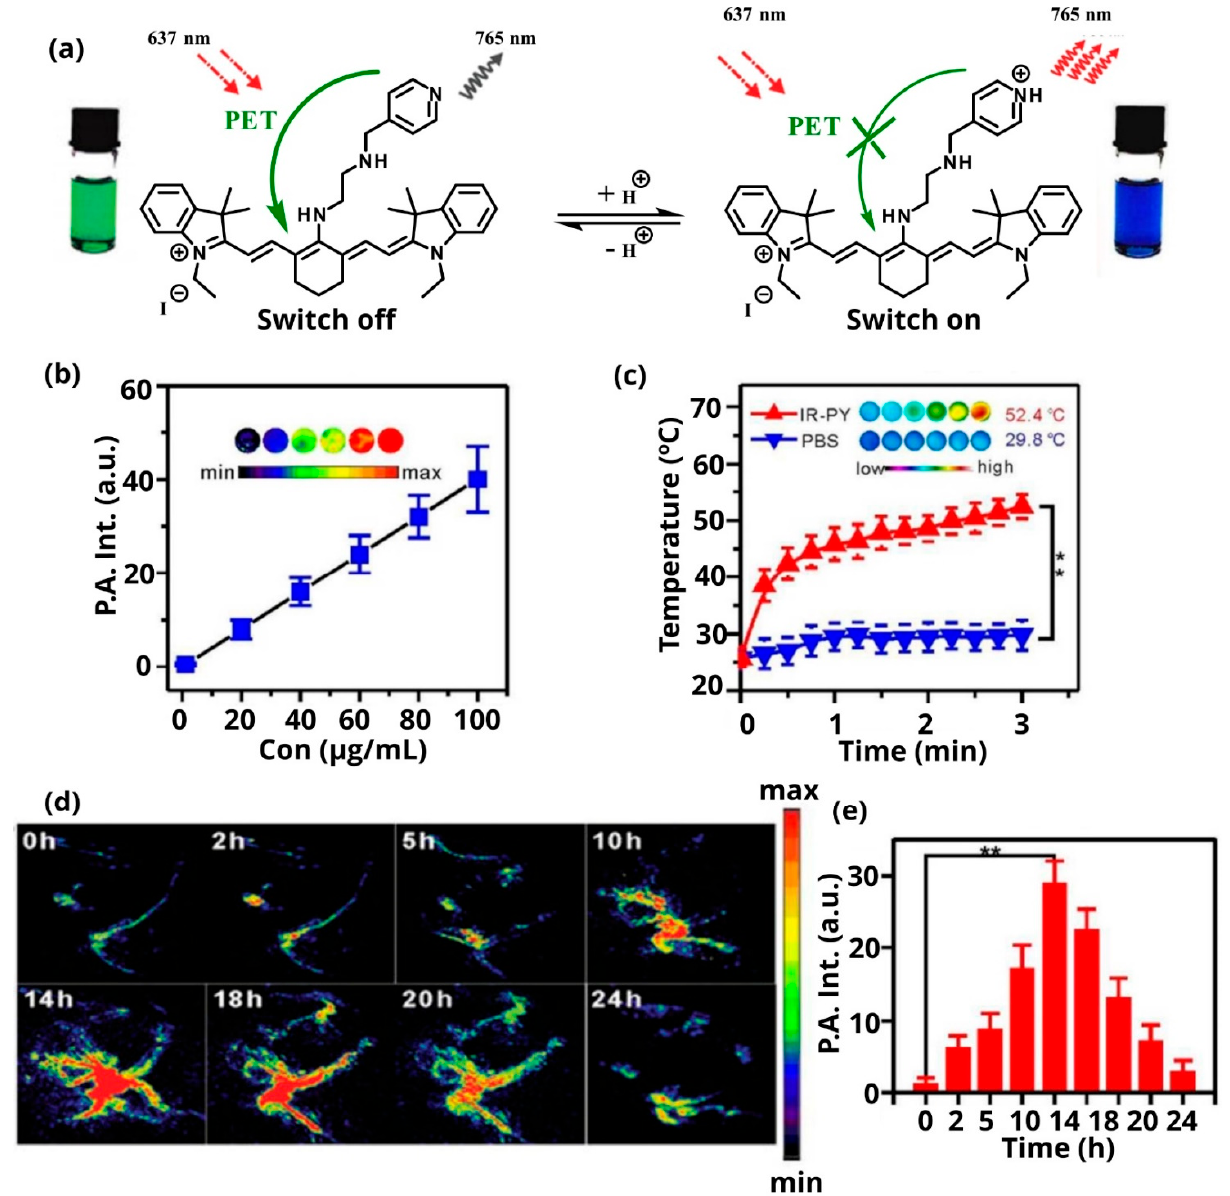
Figure 11. ( a ) Schematic diagrams of the IR-PY, pH sensing conjugates; ( b ) presentation of the positive increase of the photoacoustic signal of IR-PY in different concentrations; ( c ) photothermal temperature curves of IR-PY and control solution - PBS buffer- under continuous laser irradiation within 3 min; ( d ) PAI in vivo and ( e ) PA signal diagram intensity increment (** p < 0.01) of MCF-7 tumor-bearing living nude mice at indicated time points after in vivo injection of IR-PY. Adapted with permission from [123], Royal Society of Chemistry, 2017.